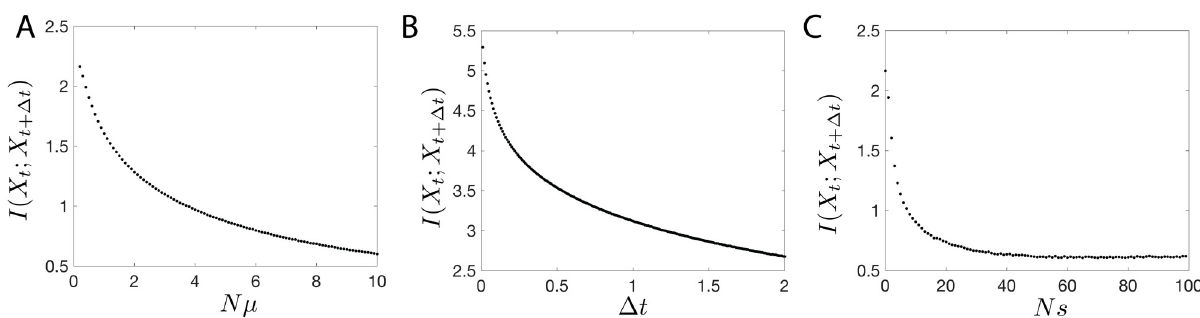
Fig 10. Amount of predictive information in the Wright Fisher dynamics as a function of model parameters. (a-c), Value of the asymptote of the information bottleneck curve, I ( X t ; X t + Δ t ) with: (a) N = 100, Ns = 0.001, Δ t = 1 as a function of μ ; (b) N = 100, Nμ = 0.2, Ns = 0.001 as a function of Δ t ; and (c) N = 100, Nμ = 0.2, and Δ t = 1 as a function of s